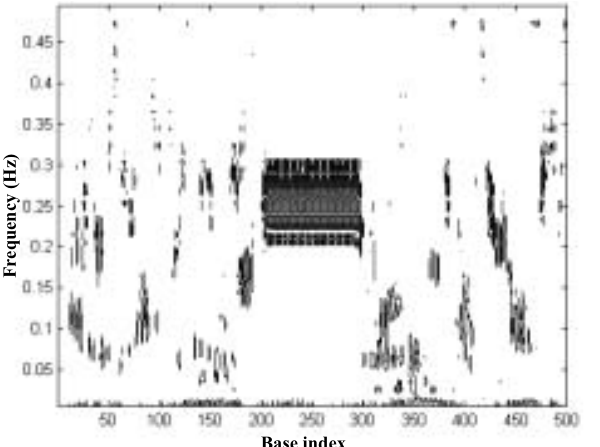
Figure 9 A section of gene sequence from GenBank (accession nr AF440524).